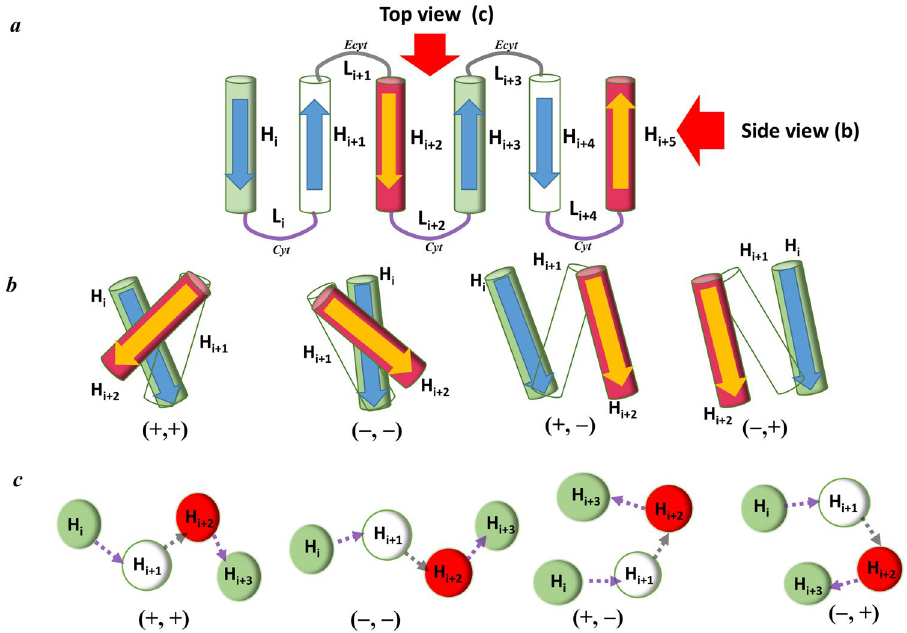
Figure 7. Relation of the dihedral angle patterns and helical arrangements or extensions. ( a ) Front view of the linearly ordered helical membrane proteins with the TM helices and loops. ( b ) Side view of the arrangement of three consecutive helices H i -H i + 1 -H i + 2 depending on the four different patterns of two consecutive Ω type angles, Ω i -Ω i + 1 . ( c ) Top view configuration of four consecutive helices, H i -H i + 1 -H i + 2 -H i + 3 , for the four different patterns of two consecutive λ type angles, λ i - λ i + 1 . Figure 7(a) and (b) were generated as follows. (1) The dihedral angles were computed by the original definition in the Fig. 2, (2) arrangement of helices was predicted based on the dihedral angles, and then (3) the predicted arrangement was drawn based on side view and top position. Zig-zag conformation denotes the helices are arranged or extended in the alternative direction as depicted in ++ and −−